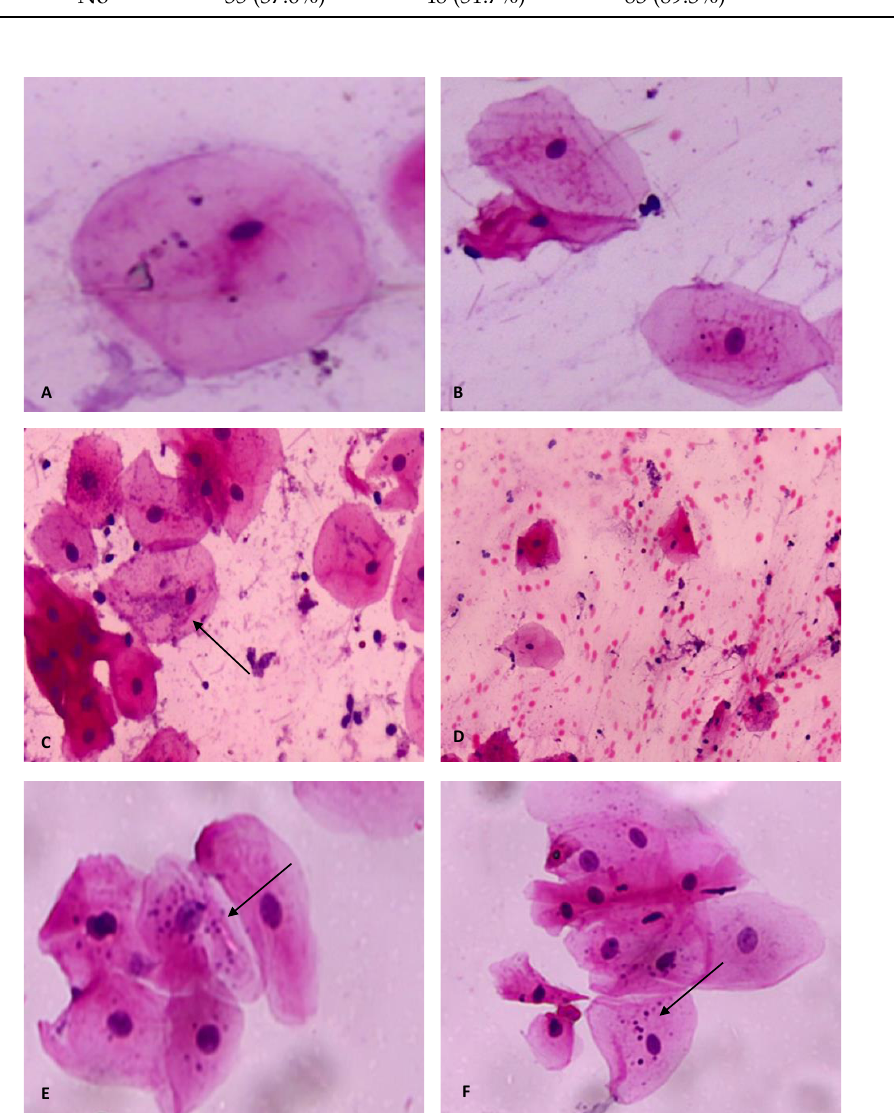
Figure 3. Cytological smears (X40), showing ( A , B ): Keratinization and cytoplasmic vacuolization. ( C ): Microbial colonies (arrow) inflammation and overlapping. ( D ): Hemorrhage and inflammation. ( E , F ): Micronuclei